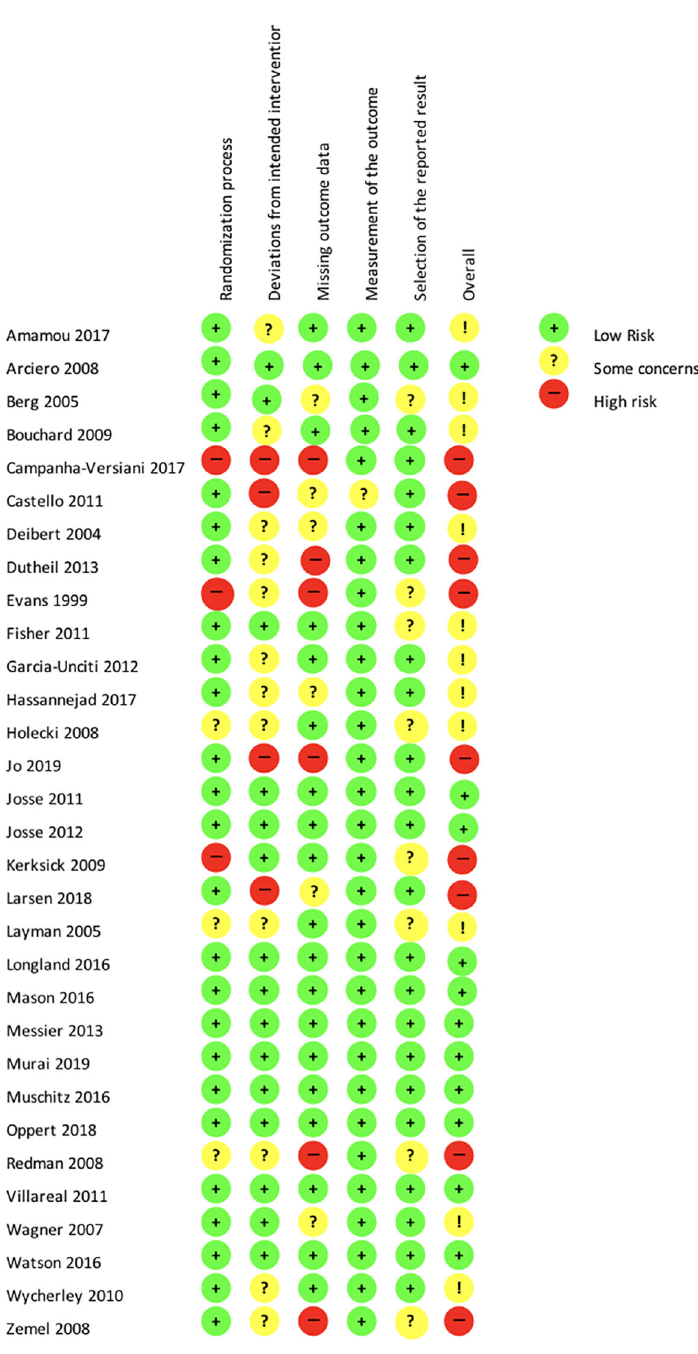
Figure 2. Riskofbias according to therevisedCochrane risk-of-bias toolfor randomizedtrials (RoB2.0).NB. “ ! ” in the “ overall ” category corresponds to “ Some concerns ”